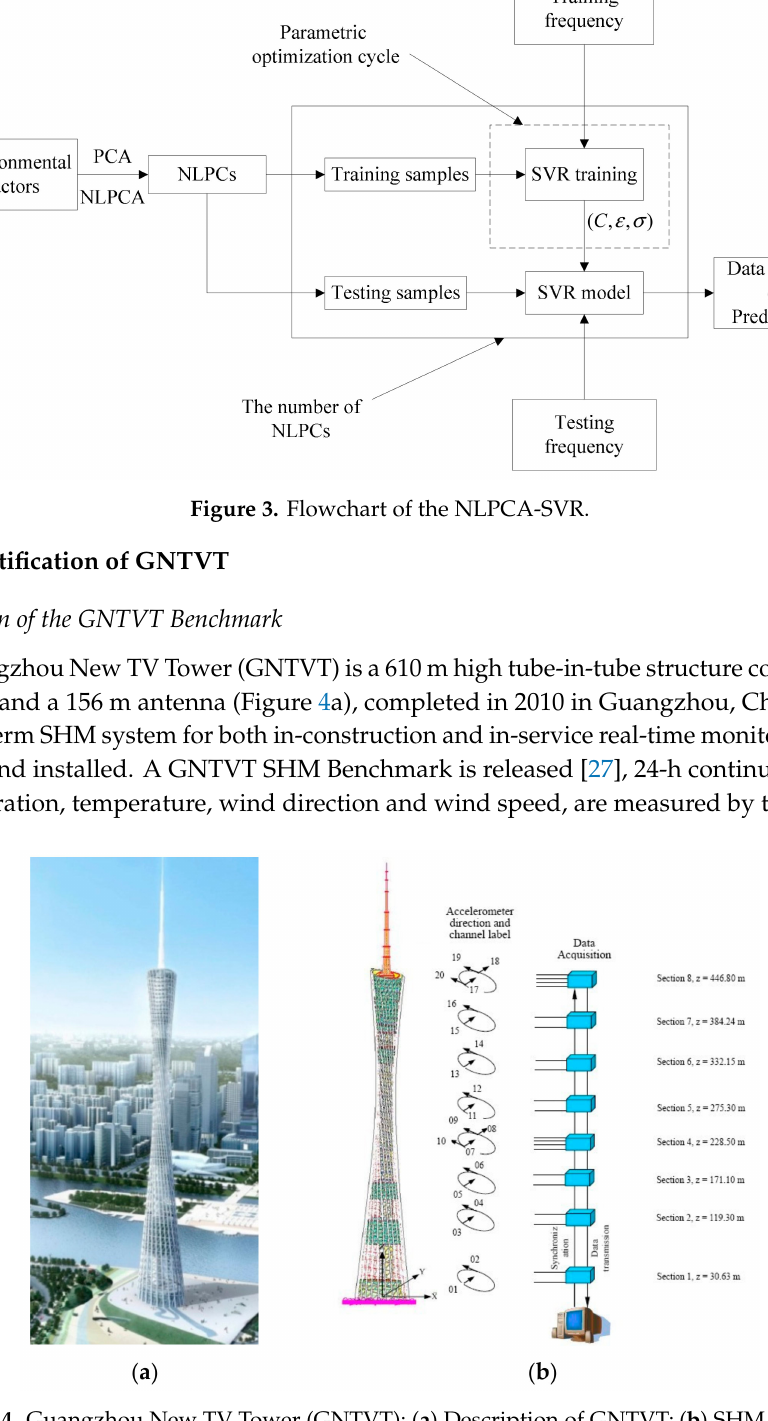
Figure 4. Guangzhou New TV Tower (GNTVT): ( a ) Description of GNTVT; ( b ) SHM